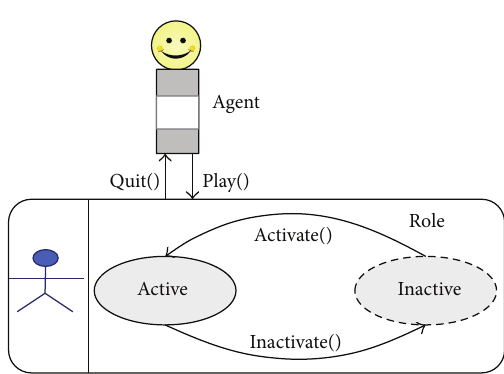
Figure 2: Mechanism of dynamically playing